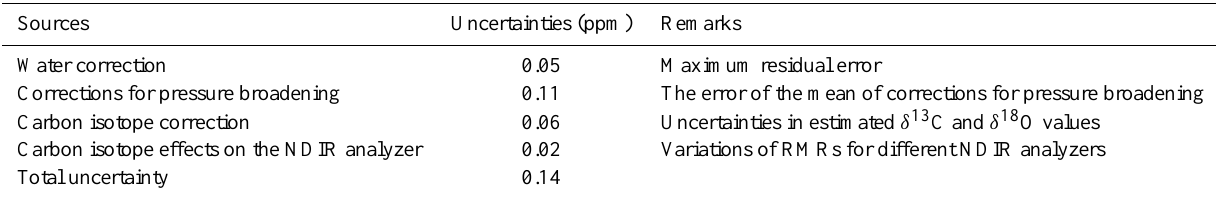
Table 4. Uncertainties related to comparison between the two CO 2 analyzers.